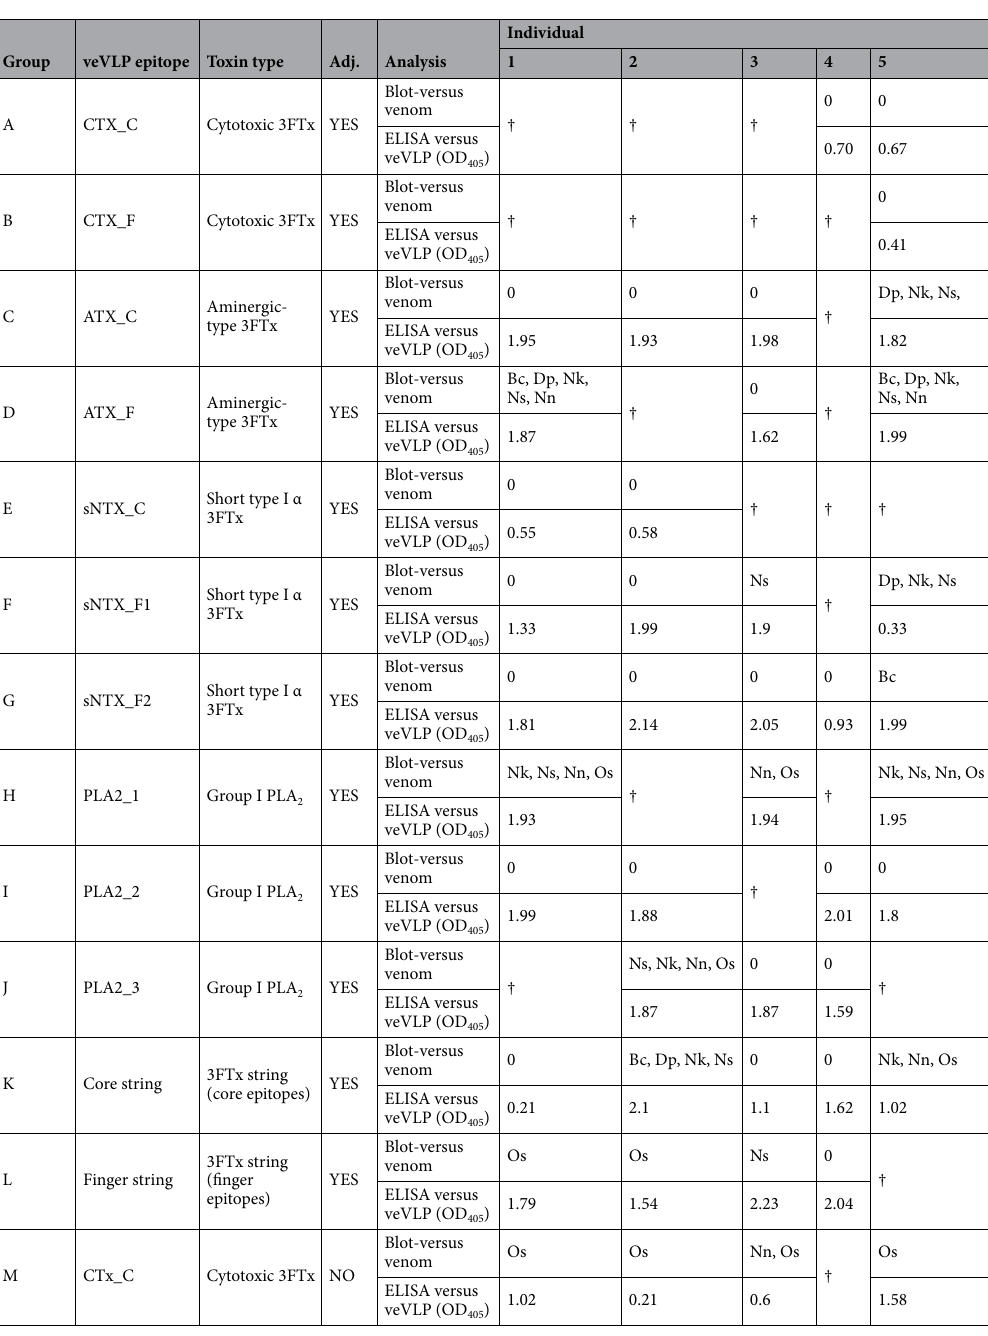
Table 2. Summary of individual animal sera recognition of veVLPs and venoms at week 14. Sera from individuals that were euthanised before the end of the experiment were unable to be analysed, as represented by the symbol †. Blot-versus venom rows denotes the venoms recognised by each animal at week 14 via immuno-blot (visual inspection of blots in File S6). Bc Bungarus candidus , Dp Dendroapsis polylepis , Nk Naja kaouthia , Ns Naja subfulva , Os Oxyuranus scutellatus, 0 no venoms recognised. ELISA versus veVLP displays absorbance values of the mean 1/500 OD 405 reading of each individual’s sera at week 14 (see Fig. 1 for more details). Adj.